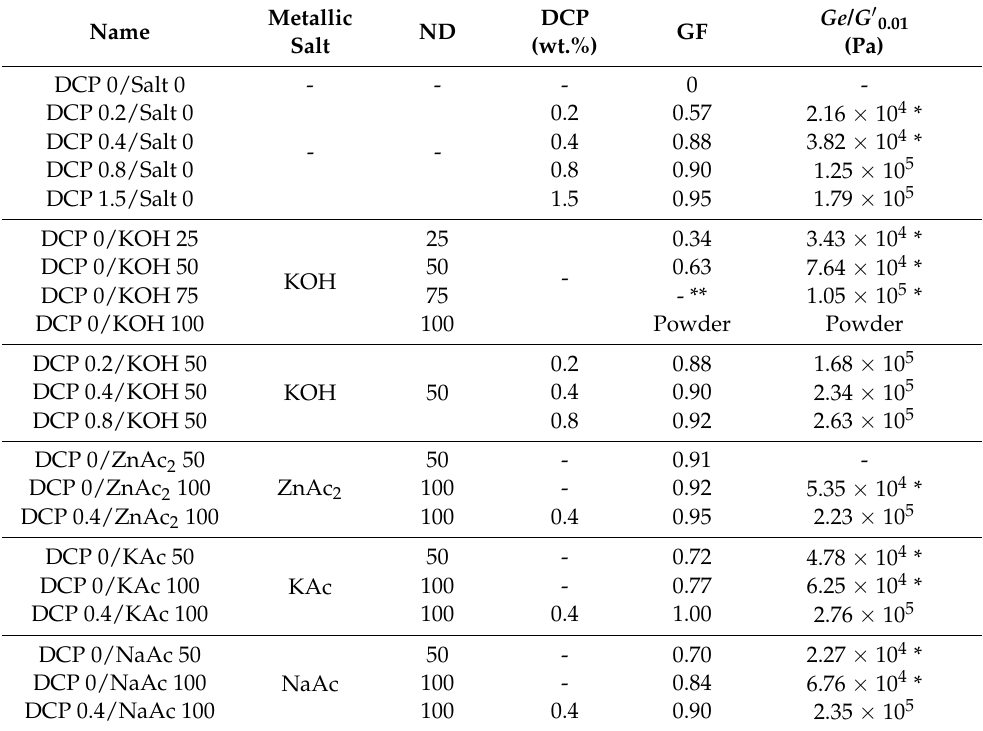
Table 2. Characteristics of the different blends. ND is the neutralization degree of the maleic anhydride on the polymer. GF is the gel fraction, Ge is the equilibrium modulus, and * G (cid:48) 0 . 01 is the storage modulus G (cid:48) measured at the lowest frequancy, i.e., ω = 0.01